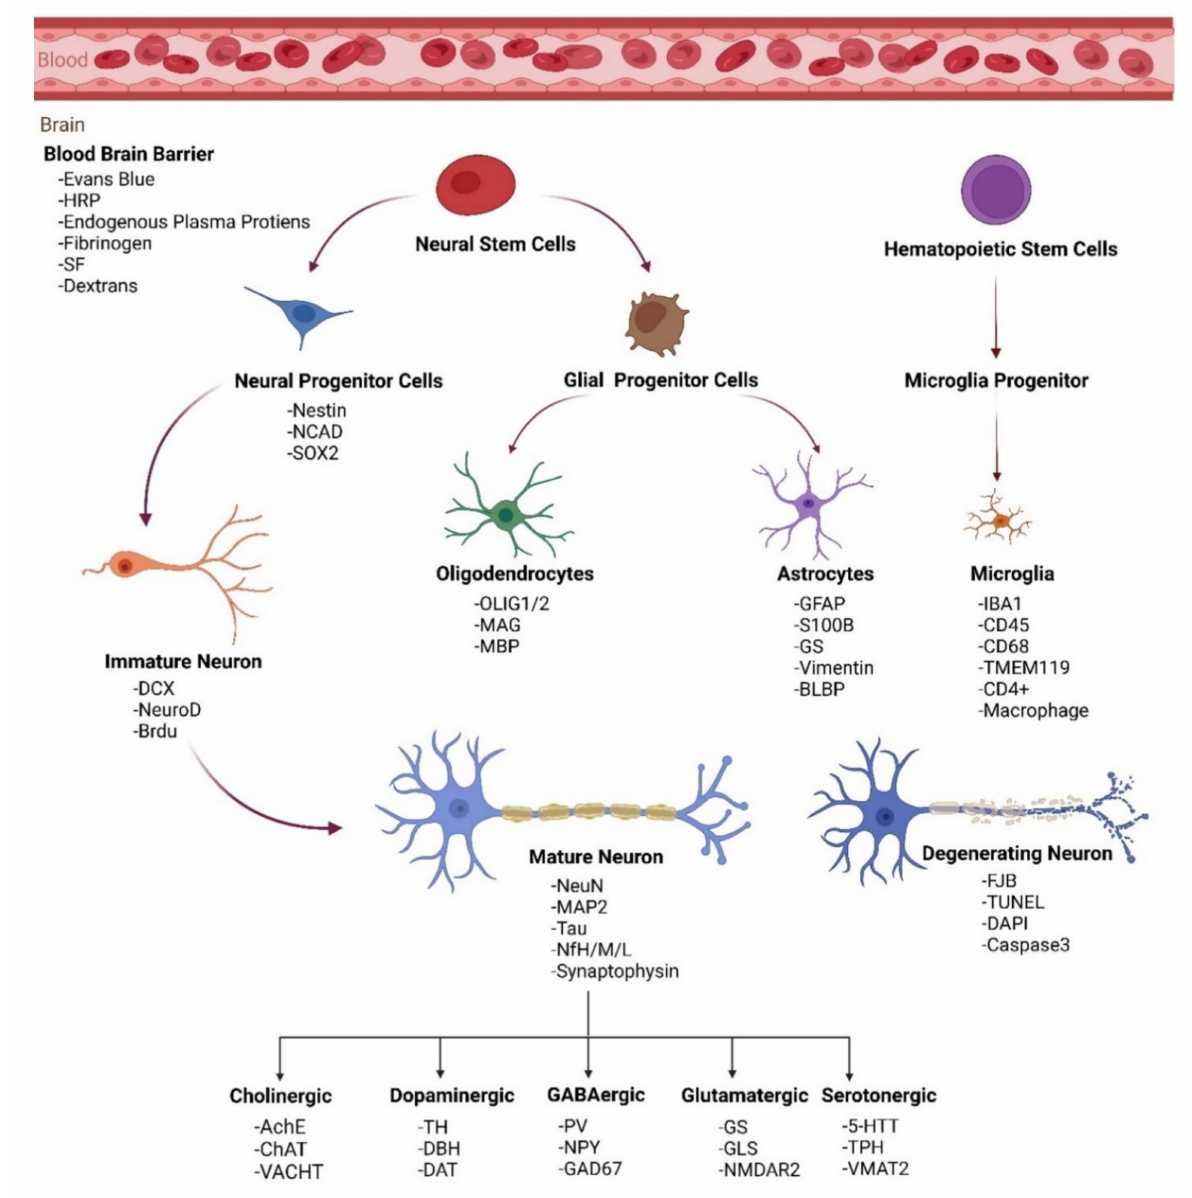
Figure 1. Cell-type-specific biomarkers for brain disorders . Schematic representation of neural differentiation and potential neural-specific biomarkers for neurodegeneration and neuronal